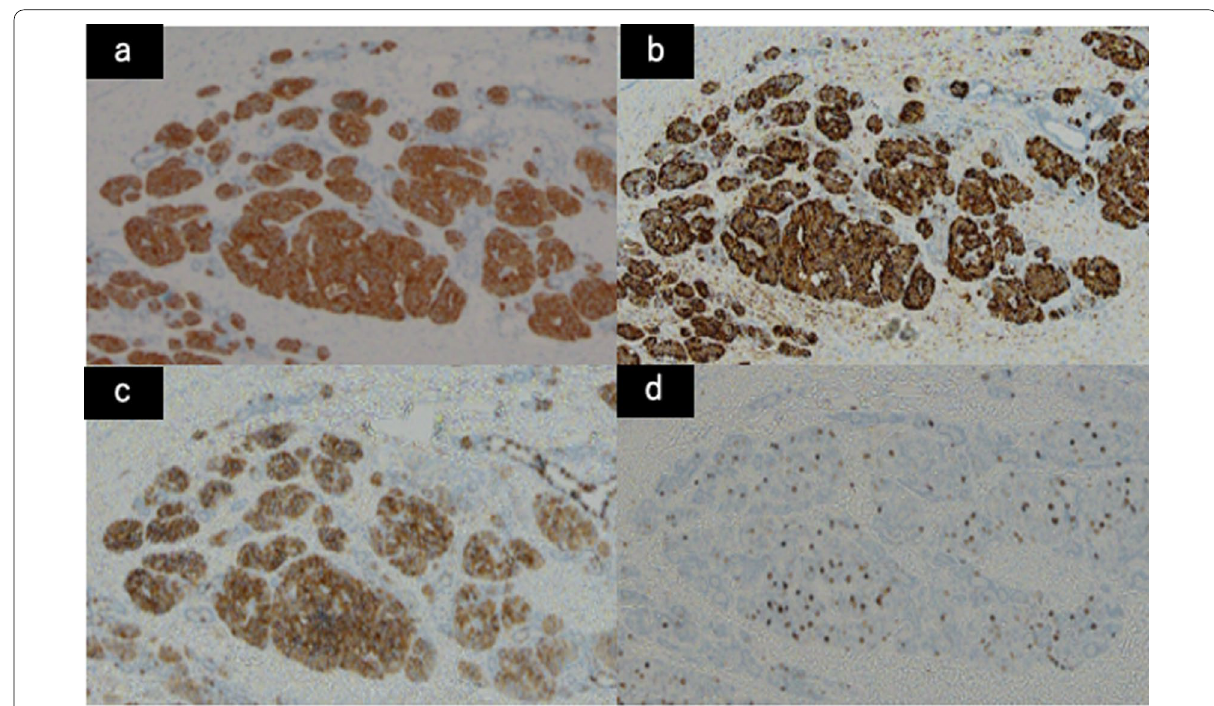
Fig. 6 Immunohistologically, a small part of these cells was diffusely positive for synaptophysin ( a ), chromogranin A ( b ) and CD 56 ( c ), confirming neuroendocrine differentiation. The tumor had five mitoses per ten high power fields, and the Ki-67 proliferation index was 8.0% ( d ), consistent